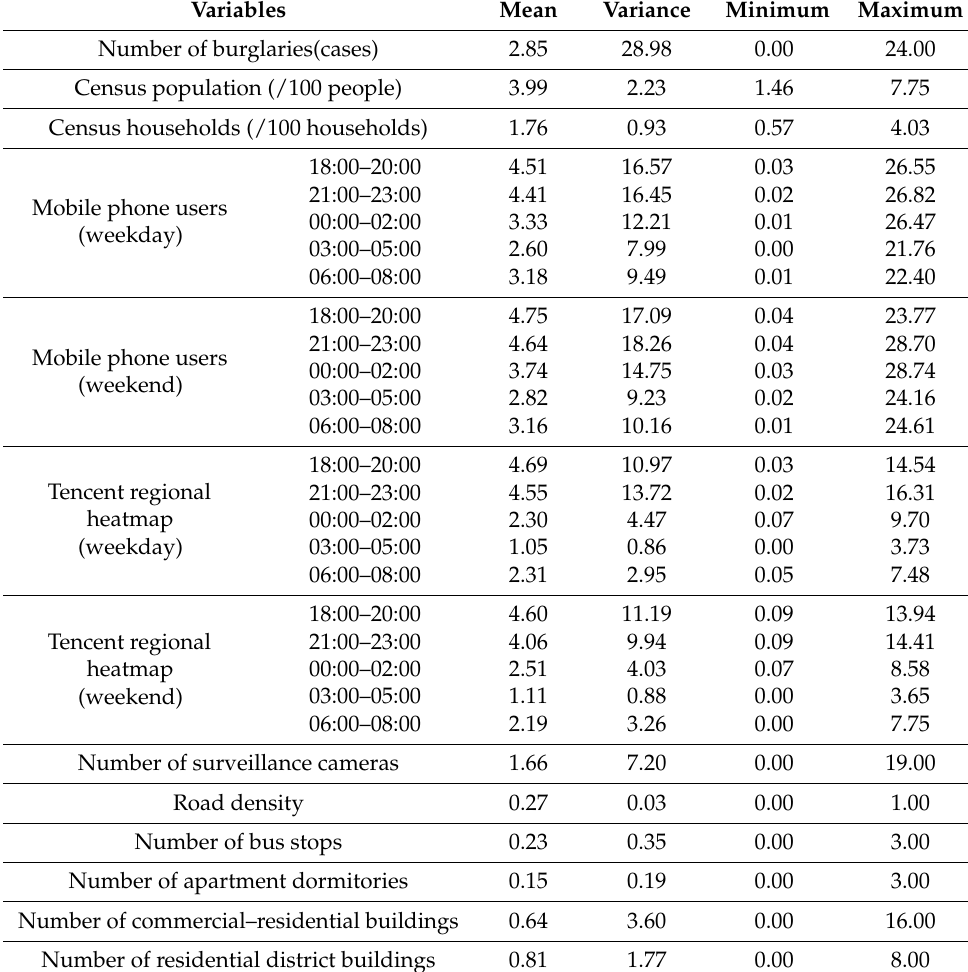
Table 1. Summary of the statistics of the variables (N = 192 sample grid